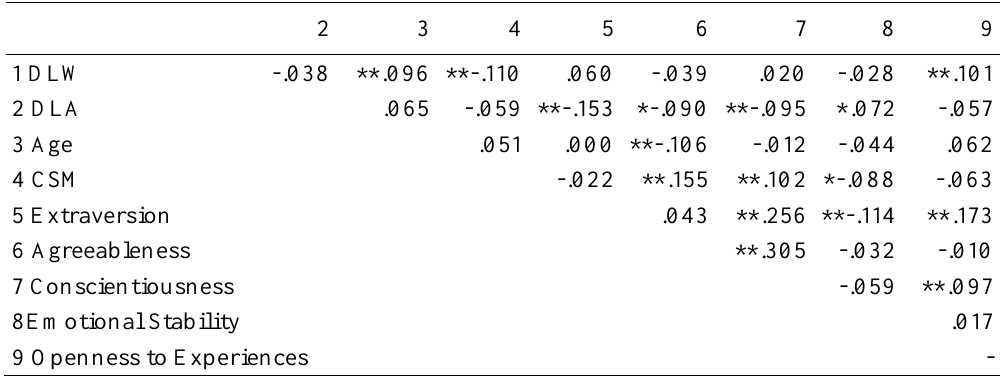
Correlations between Study